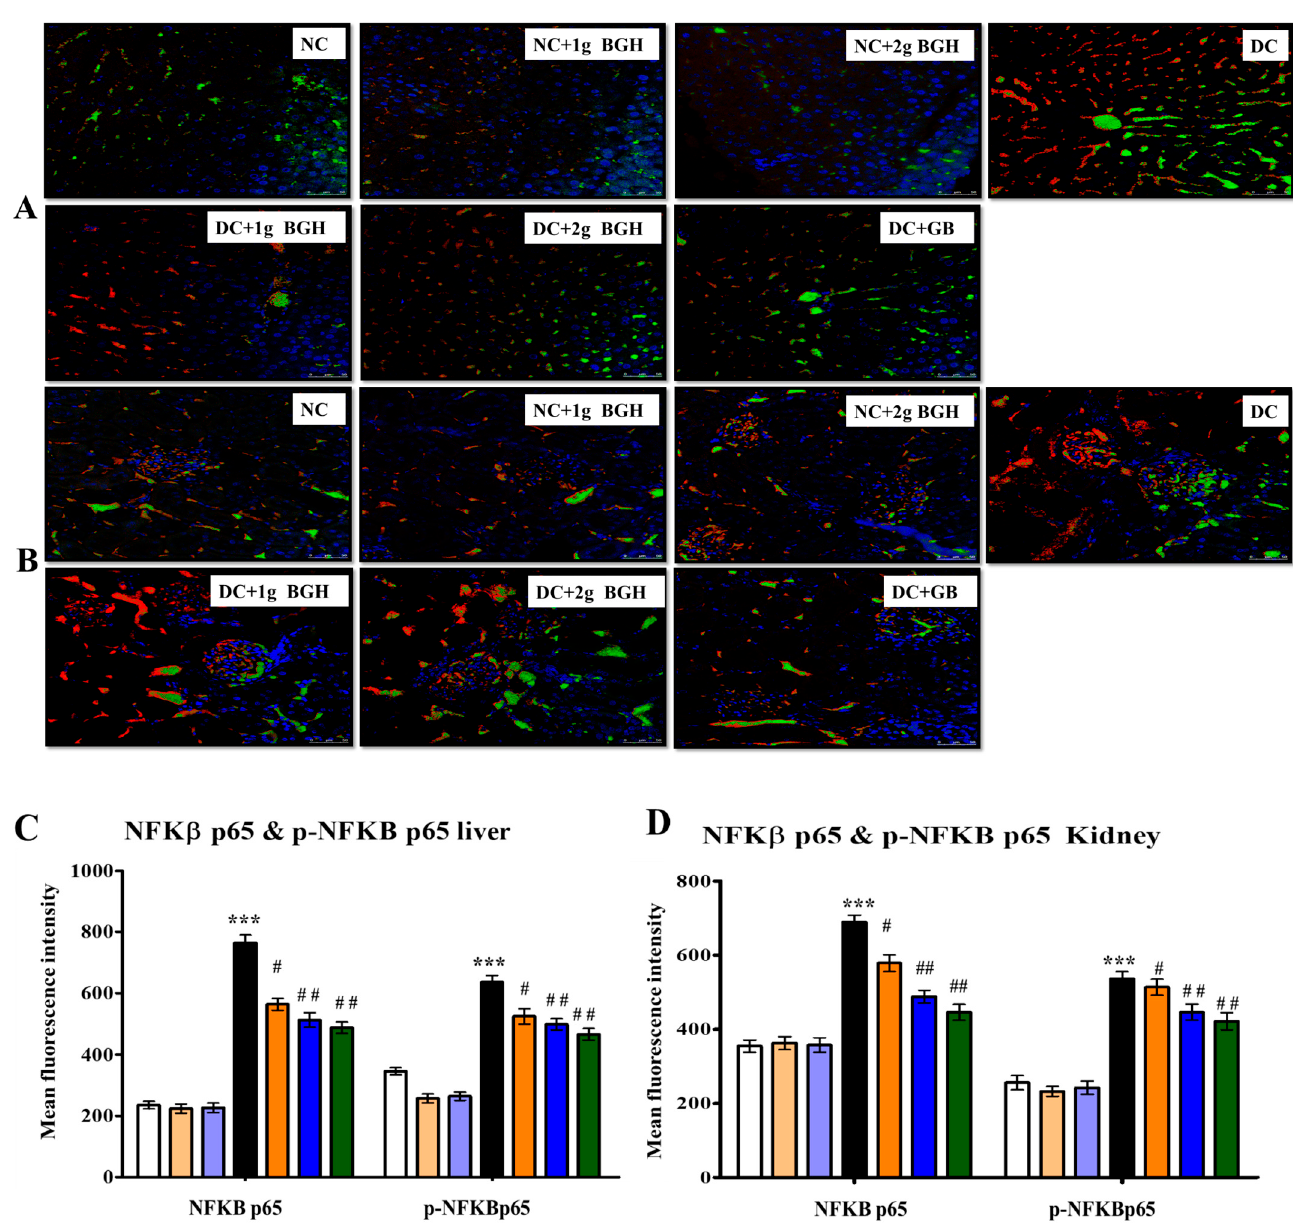
Figure 7. Representative confocal images of inflammatory markers p-NF- κ B (red) and NF- κ B (green) double immunofluores- cence staining in the liver ( A ) and kidney ( B ) samples from BGH-treated rats. Quantitative analyses of immunofluorescence signals in the liver ( C ) and kidney sections ( D ). Data were obtained from six different rats in each treatment group and expressed as mean ± S.E.M. *** p < 0.001 vs. NC; # p < 0.05; ## p < 0.01 vs. DC. S Scale bar = 100 μ m. NC: Normal control; NC+1g BGH: Non-diabetic rats that received 1 g/kg/day BGH; NC + 2 g BGH: Non-diabetic rats that received 2 g/kg/ day BGH; DC: Diabetic control; DC + 1 g BGH: Diabetic rats that received 1 g/kg/day BGH; DC + 2 g BGH: Diabetic rats that received 2 g/kg/day BGH; DC + GB: Diabetic rats that received 2 mg/kg/day glibenclamide.